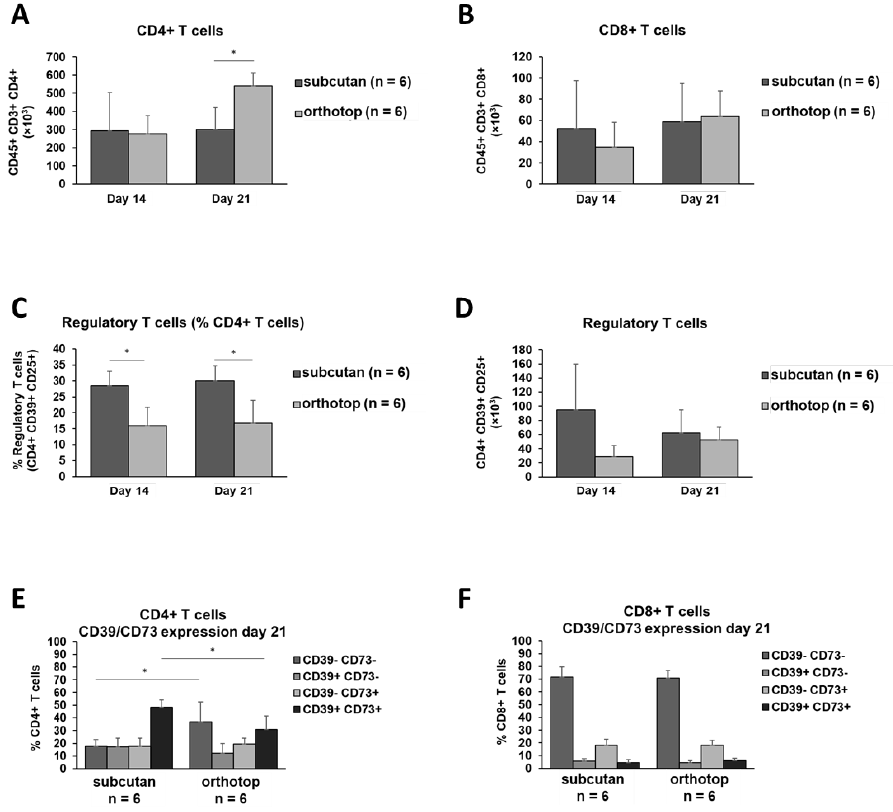
Figure 4. T cell populations in the tumor of orthotopic and subcutaneous HNSCC-bearing mice. ( A – D ) Tumors were harvested 14 days and 21 days after tumor induction, and populations of CD4 + and CD8 + T cells and regulatory T cells were analyzed using flow cytometry. ( E , F ) The expression profile for CD39/CD73 was determined on CD4 + and CD8 + T cells. On day 14 and day 21, the test group size for the subcutaneous group was n = 6, and for the orthotopic group n = 6. p -values < 0.05 were considered to be significant with (*). Data shown here are listed in Table S1.